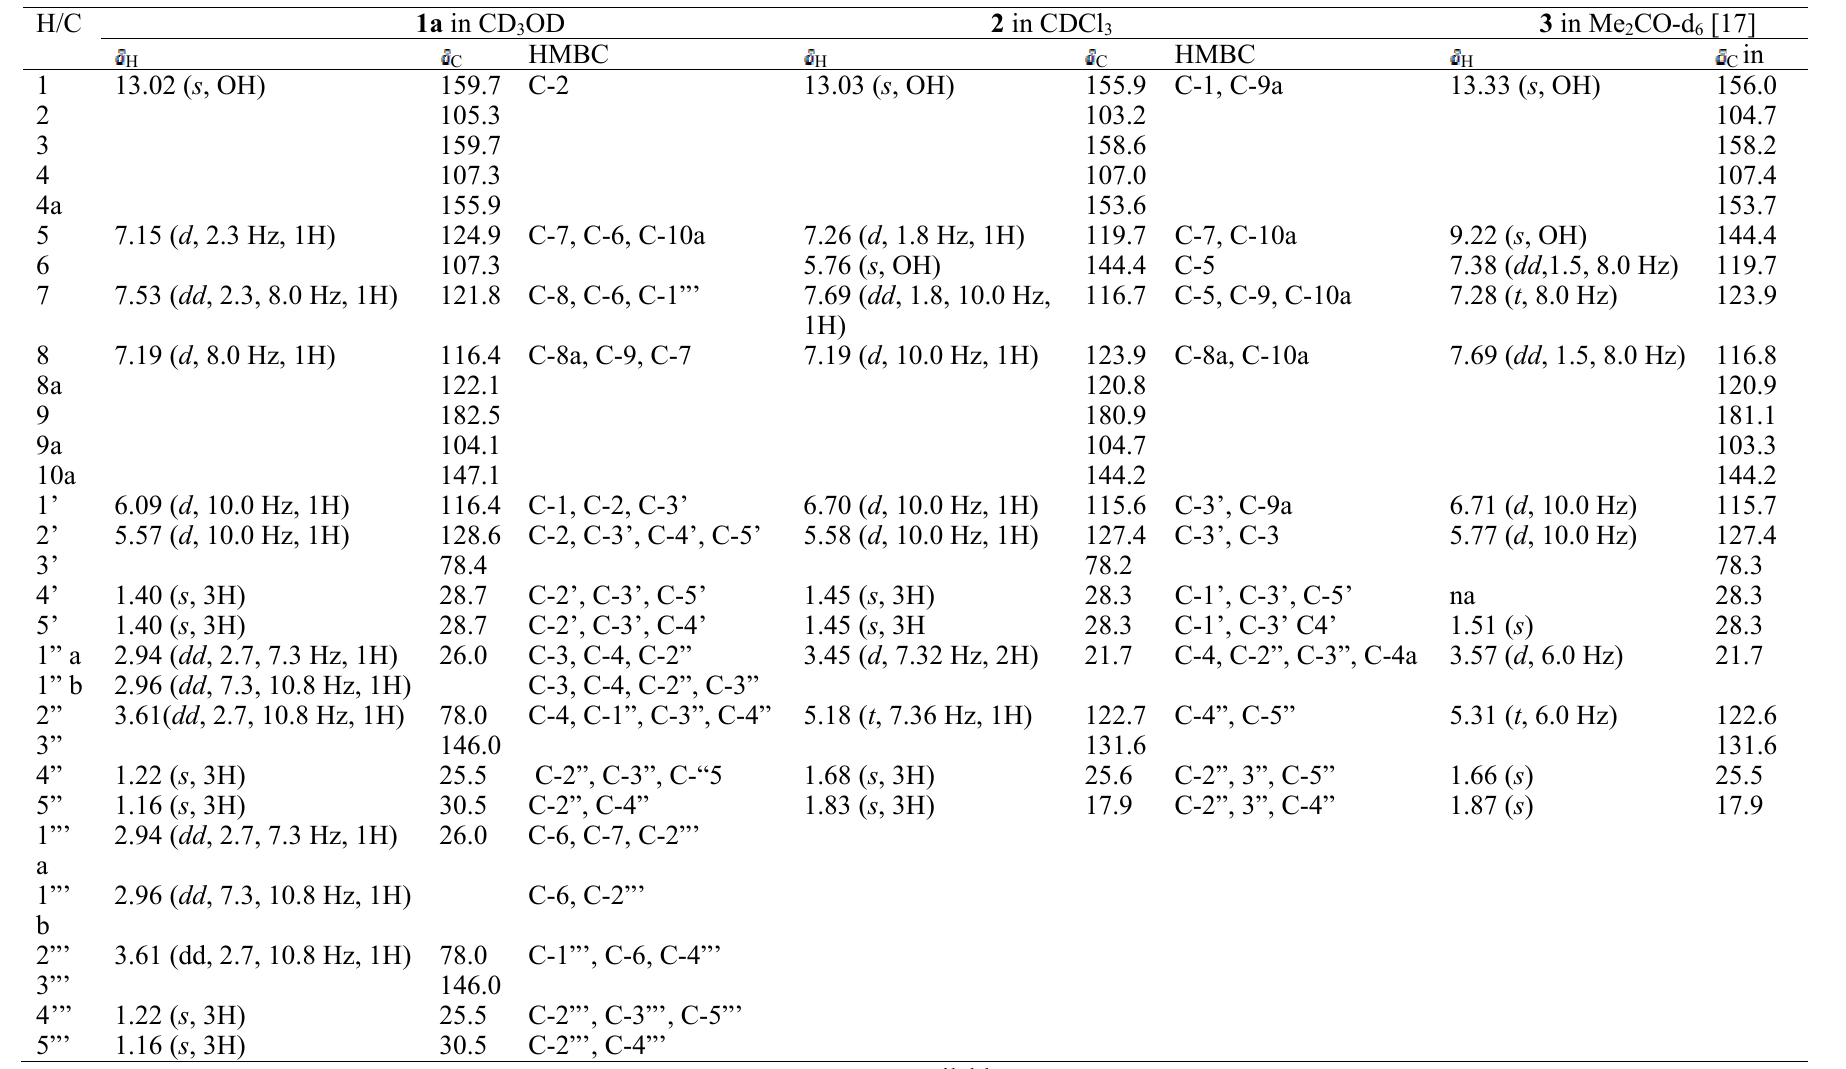
Table 1. 1 H-NMR and 13 C- NMR spectral data of 1a , 2 and 3